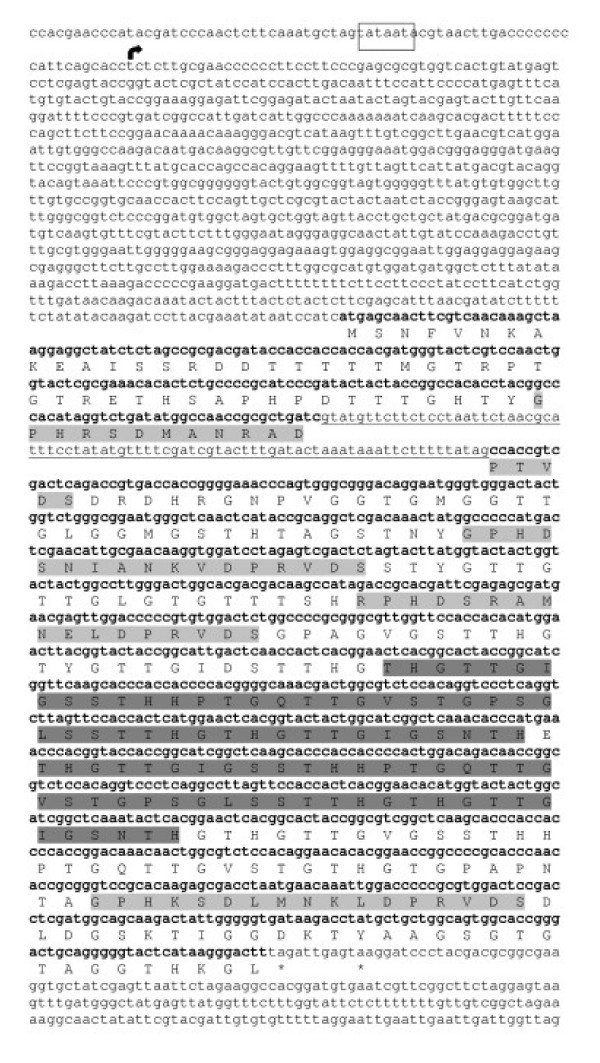
Nucleotide and amino acid sequences of TbDHN1. Genomic and mRNA were sequenced by genomic and cDNA library screening. The coding sequence is shown in bold lower case; the 79-bp-long intron is underlined. The putative TATA box is indicated by an open box.  indicates the transcription initiator. Stop codons are marked with an asterisk. AA amino acids that form the CSP; AA amino acids that form the repeated block of 46 amino acids.